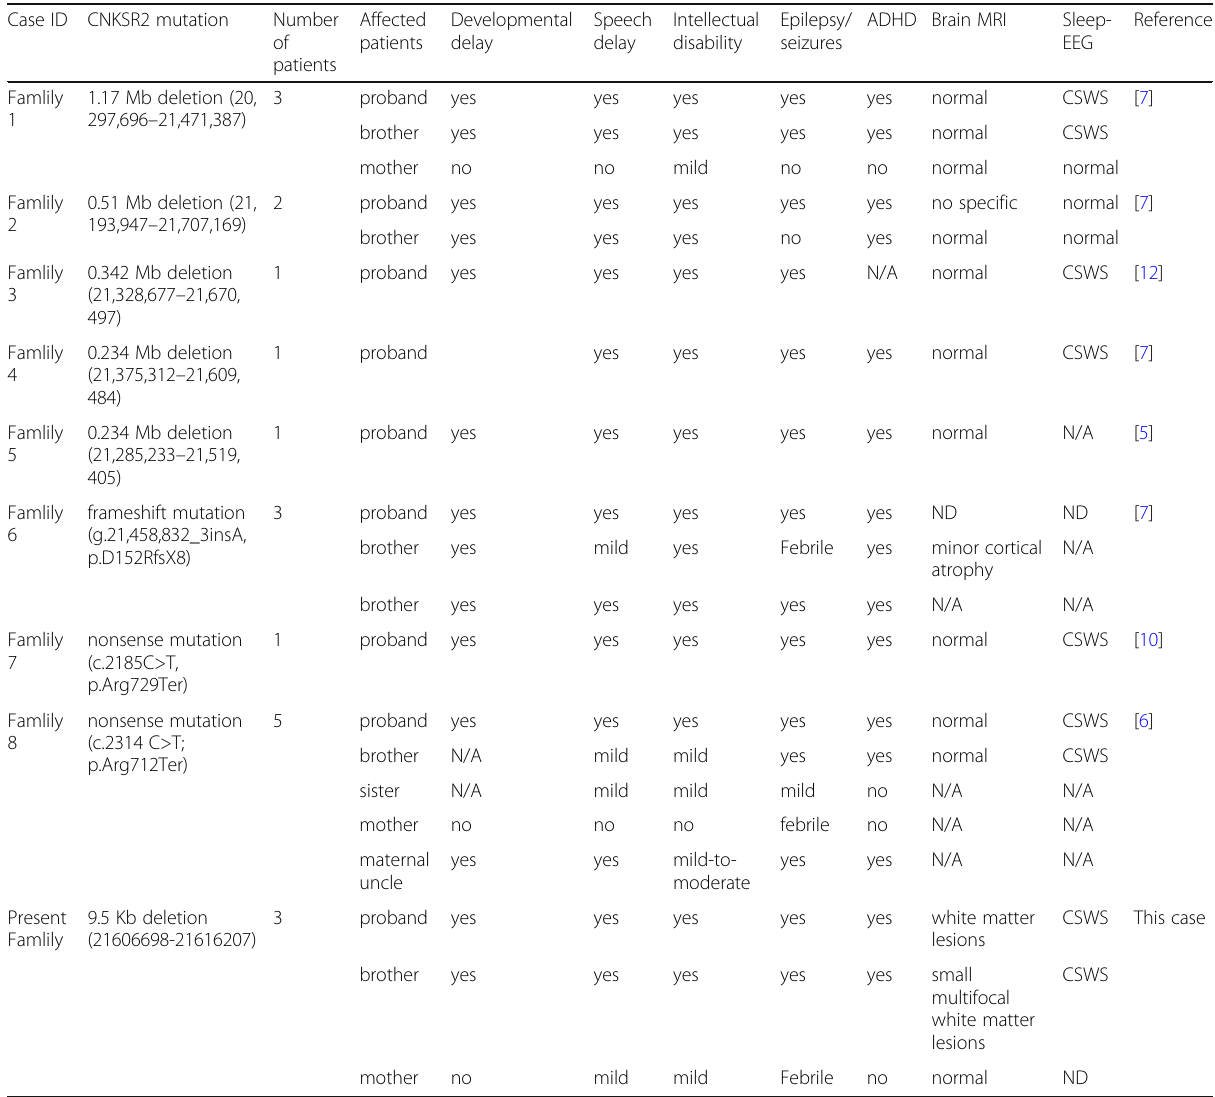
Table 1 Genetic and clinical details of 9 families with CNKSR2 deficiency Case ID CNKSR2